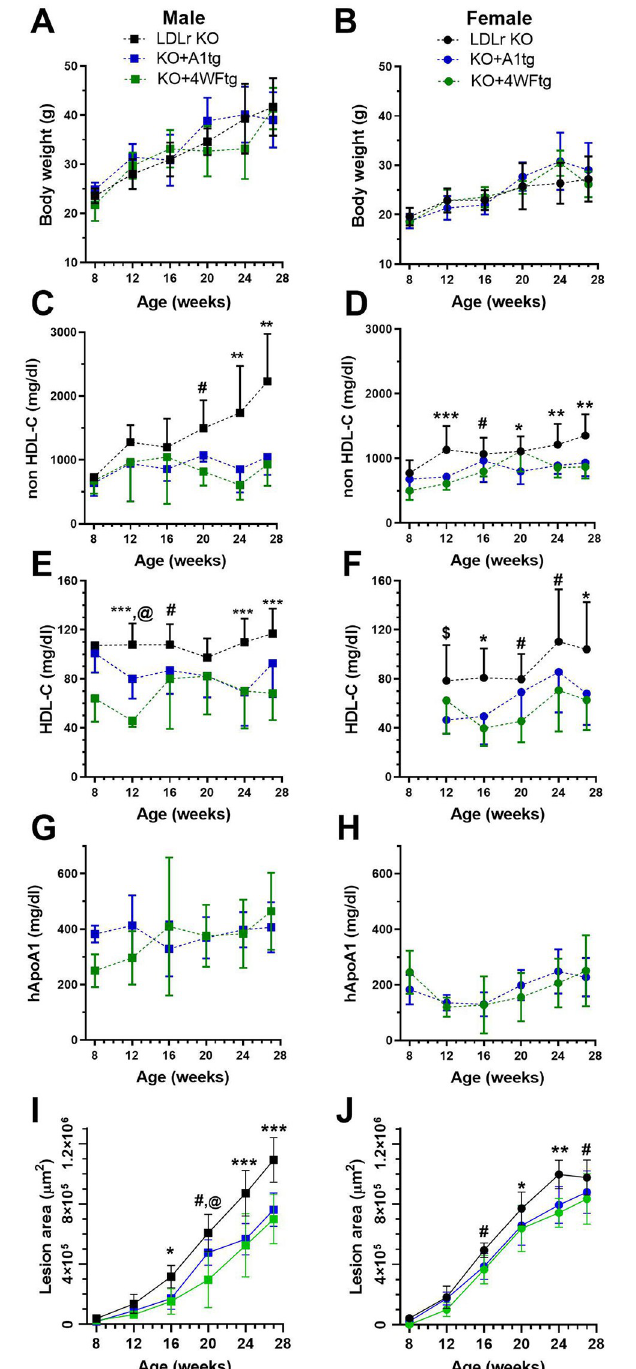
Fig 1. Lesion progression time course in male (square symbols, left side) and female (round symbols, right side) mice. A,B . Body weights during the progression time course. C,D . Non-HDL-C levels. E,F . HDL-C levels. G,H . human apoA1 levels. I,J . Aortic root lesion areas. For all panels, black symbols are LDLr KO mice, blue symbols are LDLr KO expressing the wild type human apoA1 transgene (KO+A1tg); and green symbols are LDLr KO expressing the 4WF apoA1 transgene (KO+4WFtg). Mean ± SD; two way ANOVA p-values: #, p < 0.05 for LDLr KO vs. KO +4WFtg; @, p < 0.05 for KO+A1tg vs. KO+4WFtg; $, p < 0.05 LDLr KO vs. KO+A1tg; � , p < 0.05 for LDLr KO vs. both transgenic isoforms; �� , p < 0.01 for LDLr KO vs. both transgenic isoforms; ��� , p < 0.001 for LDLr KO vs. both transgenic isoforms.